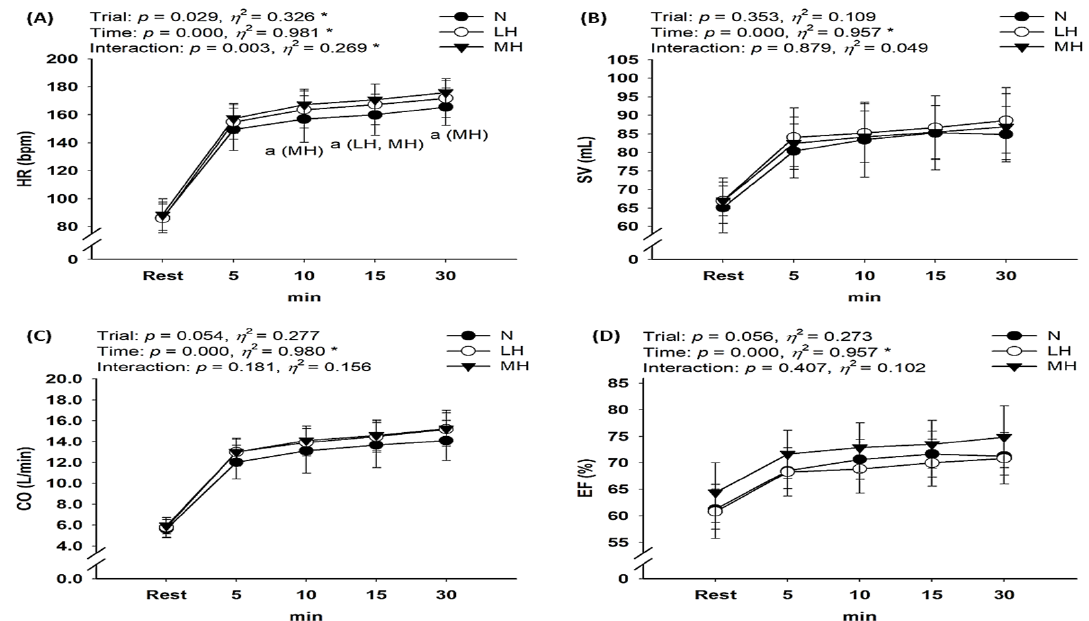
Figure 4. Changes in the cardiac function at rest and during endurance submaximal exercise. ( A ) HR, ( B ) SV, ( C ) CO, ( D ) EF. HR: heart rate; SV: stroke volume; CO: cardiac output; EF: ejection fraction; N: endurance submaximal exercise under normoxia; LH: endurance submaximal exercise under light hypoxia (596 mmHg, simulated 2000 m); MH: endurance submaximal exercise under moderate hypoxia (526 mmHg, simulated 3000 m). The bars indicate the mean ± S.D. *: Significant interaction or main effect; a: significant difference vs. normoxia; b: significant difference vs. light hypoxia.